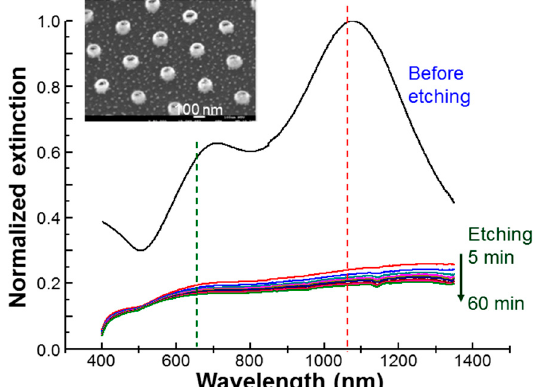
Figure 1. Normalized extinction spectra of the used NRI solutions before and after KI/I 2 etching for 5–60 min. The vertical red and green dashed lines indicate the wavelengths of used lasers at 1064 and 660 nm, respectively. The insert shows the SEM image of the used Au NRIs still on substrate.